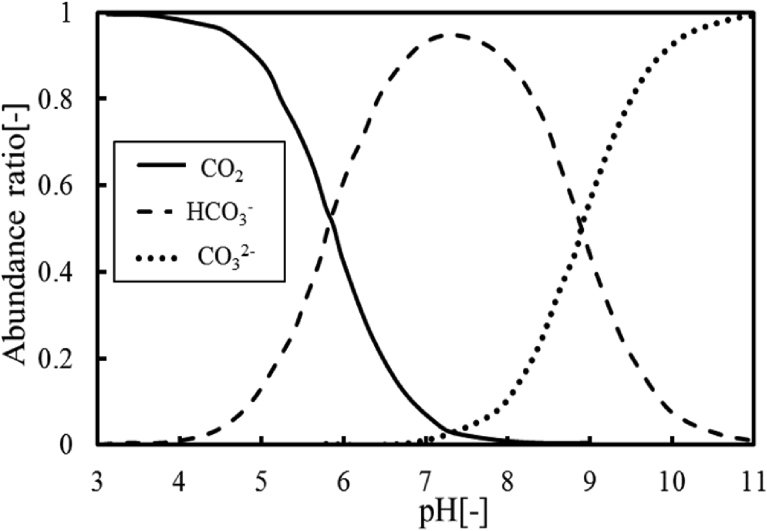
Abundance ratios of carbonic ions against pH value. (Solid line: CO2, Dashed line: HCO3-, Dotted line: CO32-).